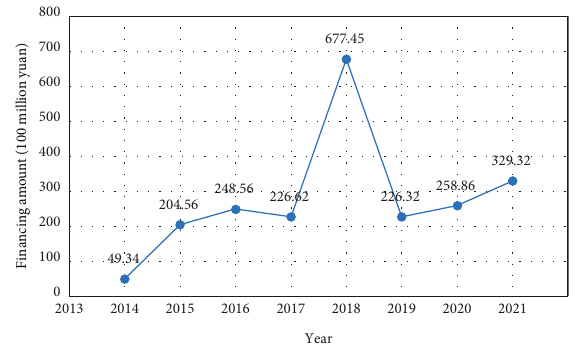
Figure 4: Financing amount in sports field in China from 2013 to